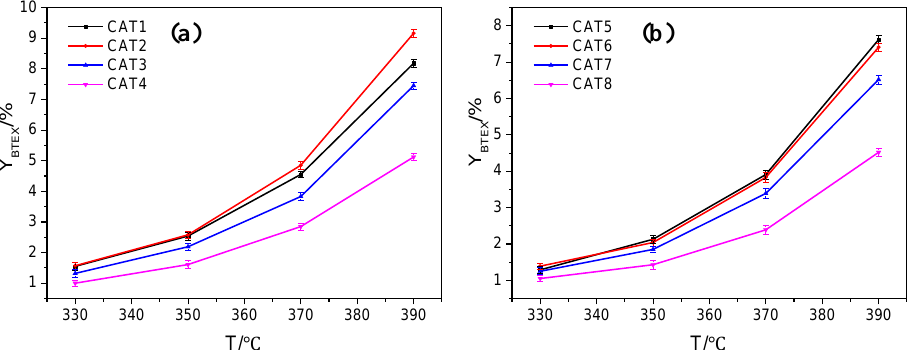
Figure 8. The relationship of yields of iso-cracking and temperature over catalysts ( a ) CAT1–CAT4 and ( b ) CAT5–CAT8.